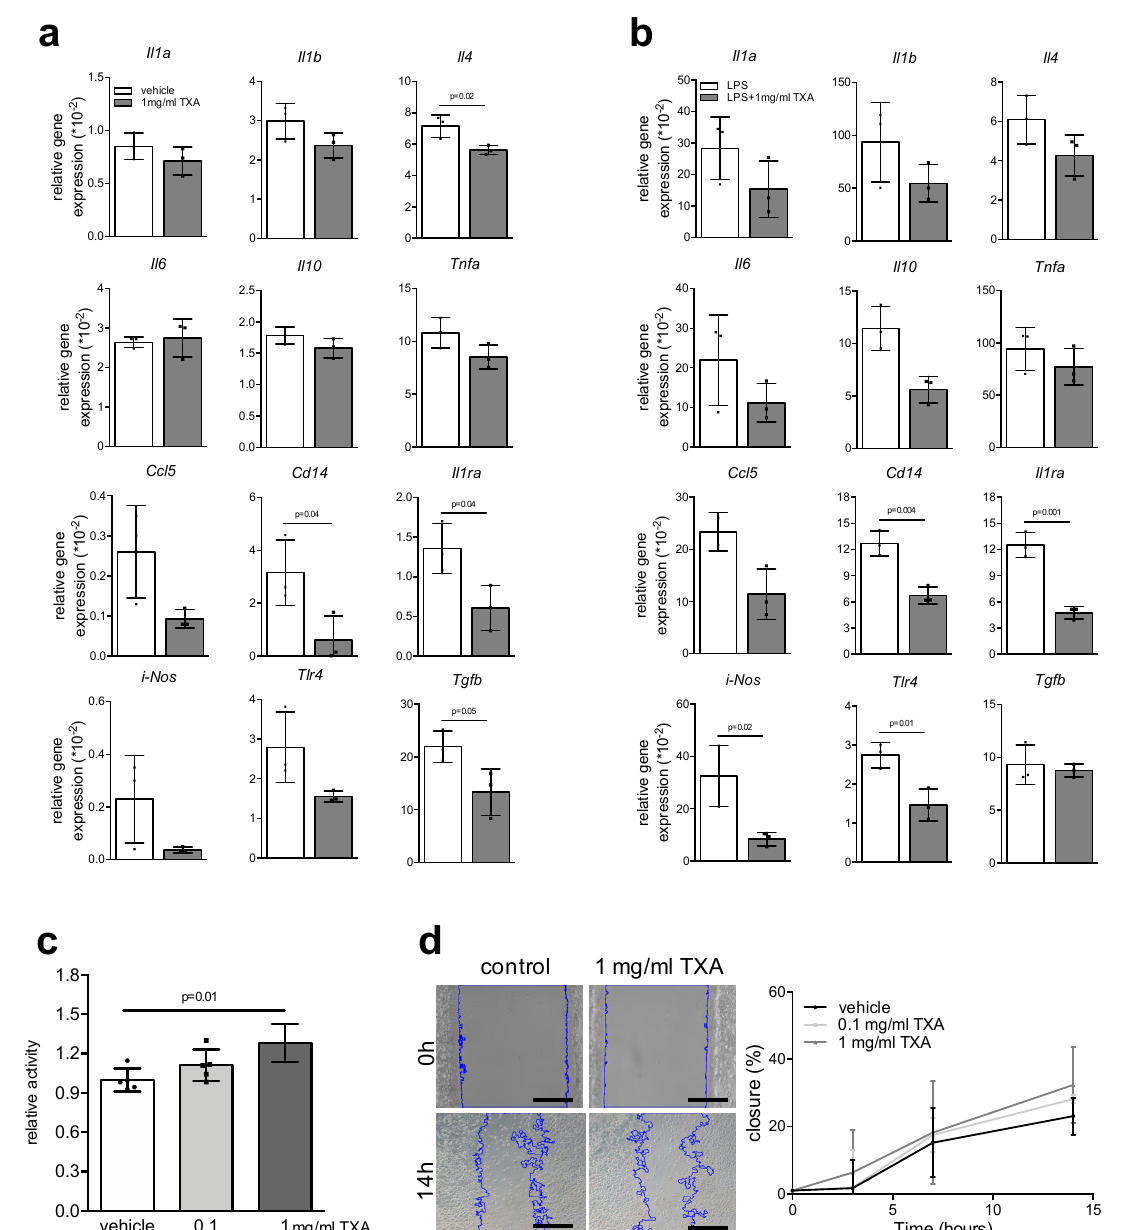
Figure 5. Modulation of cytokine responses through TXA in resting and activated macrophages. ( a ) qRT-PCR expression analysis for the indicated genes in bone marrow-derived macrophages at day 7 of differentiation, stimulated with TXA (1 mg/mL) for 6 h. ( b ) qRT-PCR expression analysis for the indicated genes in bone marrow-derived macrophages at day 7 of differentiation, activated with 1 μg/mL LPS and simultaneously co-stimulated with TXA (1 mg/mL) for 6 h. ( c ) MTT proliferation assay of bone marrow-derived macrophages stimulated with the indicated concentrations of TXA. ( d ) Representative images of macrophage migration assays using Ibidi chambers of the indicated groups and time points. Scale bars = 50 μm. Blue lines indicate spreading cell fronts. The quantification of cell migration is shown on the right. For ( a – d ), n = 3–5 independent macrophage cultures per group were used as indicated with individual data points. Data presented are means ± SD. Gene abbreviations: interleukin-1 alpha ( Il1a ), interleukin-1 beta ( Il1b ), interleukin-4 ( Il4 ), interleukin-6 ( Il6 ), interleukin-10 ( Il10) , tumor necrosis factor alpha ( Tnfa ), CC-chemokine ligand 5 ( Ccl5 ), cluster of differentiation 14 ( Cd14 ), interleukin-1 receptor antagonist ( Il1ra ), inducible NO synthase ( iNos ), toll-like receptor 4 ( Tlr4 ), transforming growth factor beta ( Tgfb ).